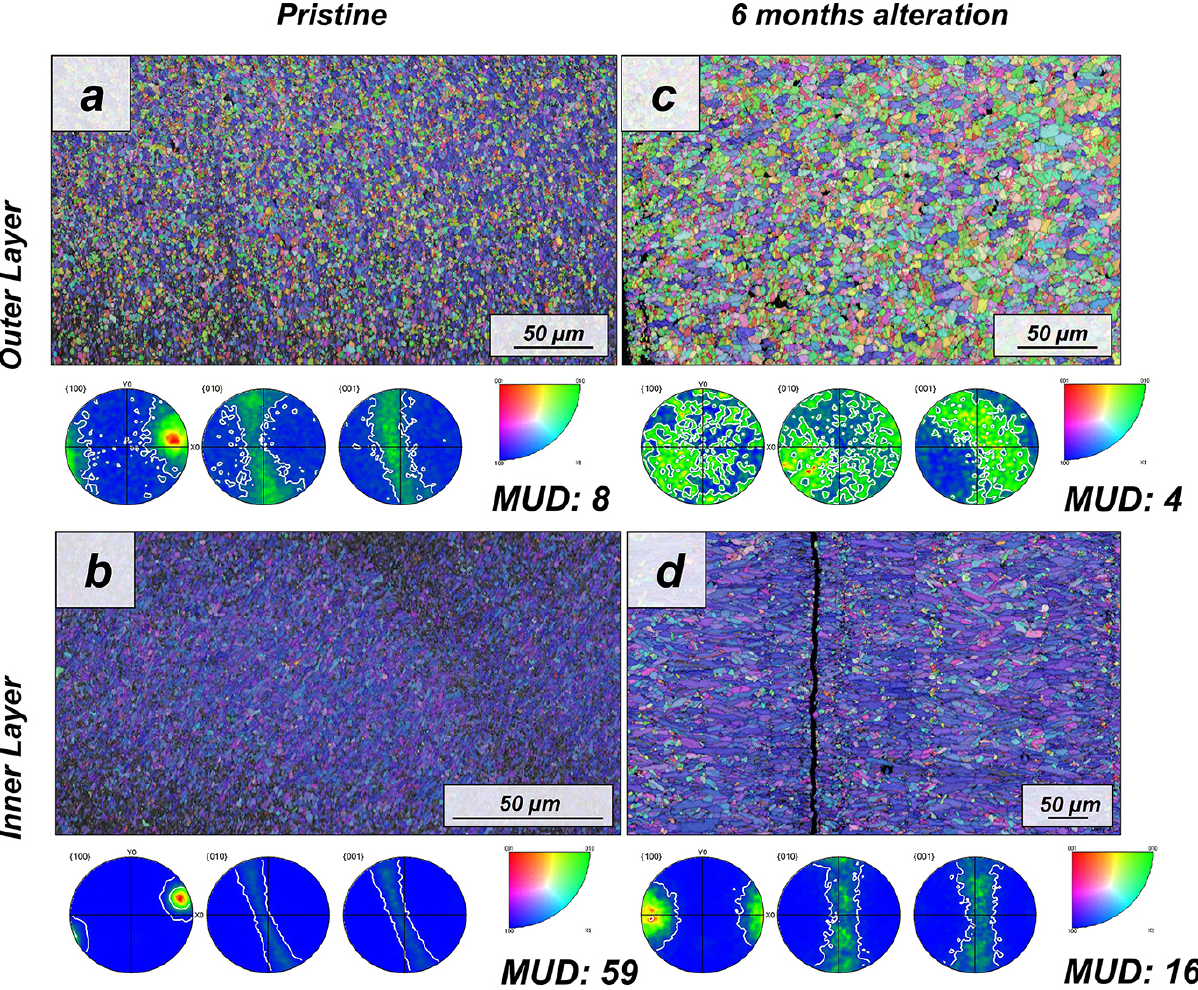
Figure 1. EBSD colour-coded orientation maps with their corresponding pole figures depicting aragonite microstructure and texture in (a, b) pristine and (c, d) altered shells of the bivalve Arctica islandica . The strength of crystal co-orientation is given with the MUD value for the relevant EBSD scan, which is shown for each EBSD measurement. Even though that, at the applied hydrothermal alteration, new abiogenic calcite formation does not yet take place, the strong decrease in MUD values between the pristine and the altered samples indicates reorganization of the microstructure through new, abiogenic, aragonite